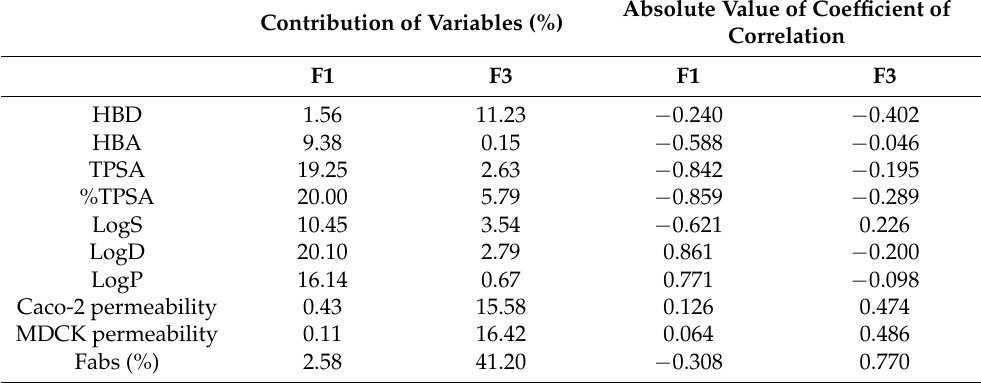
Table 2. Characteristics of principal component analysis (PCA). The left side of the table presents the relative contributions of the different variables to the main components (PC1 and PC3). The left side of the table presents the corresponding absolute values of coefficient of correlation indicating the strength of correlation.